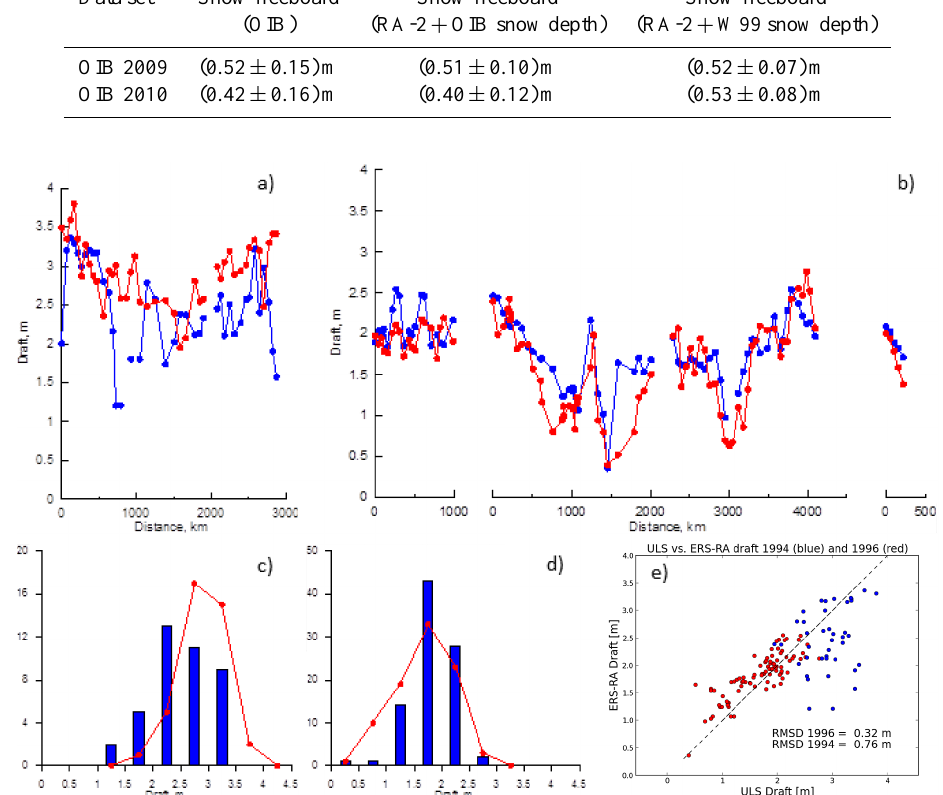
Figure 6. Comparison between sea ice draft observed from US submarine ULS (red) and computed from ERS-1 RA sea ice freeboard using W99 snow data (blue). Images (a) and (b) are profiles along submarine track for April 1994 and October 1996, respectively (see also Fig. 1); Images (c) and (d) show corresponding histograms; the y axis denotes the number of data per draft bin. Image (e) compares data from both cruises for 1994 (blue) and 1996 (red) together with the